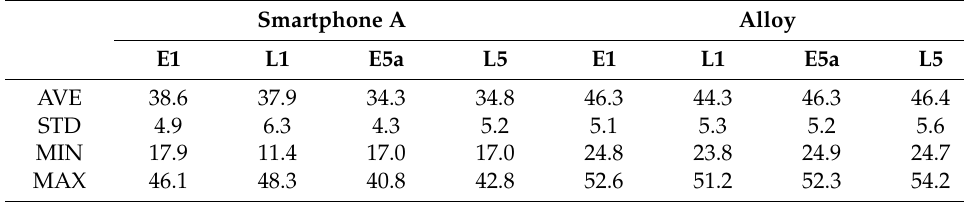
Table 4. Test 2 SNR statistics for smartphone A and Alloy receiver (units: dbHz). Smartphone A